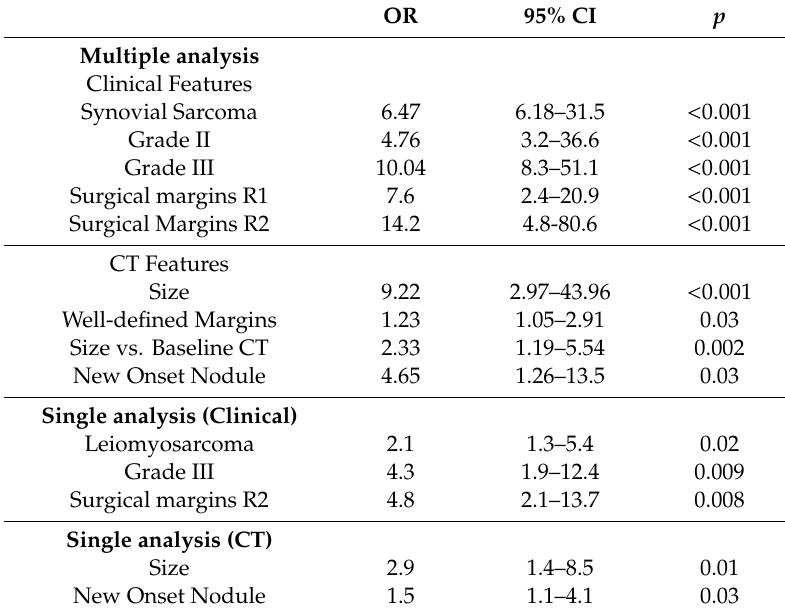
Table 3. Results of logistic regression analysis in discriminating histologic malignancy.